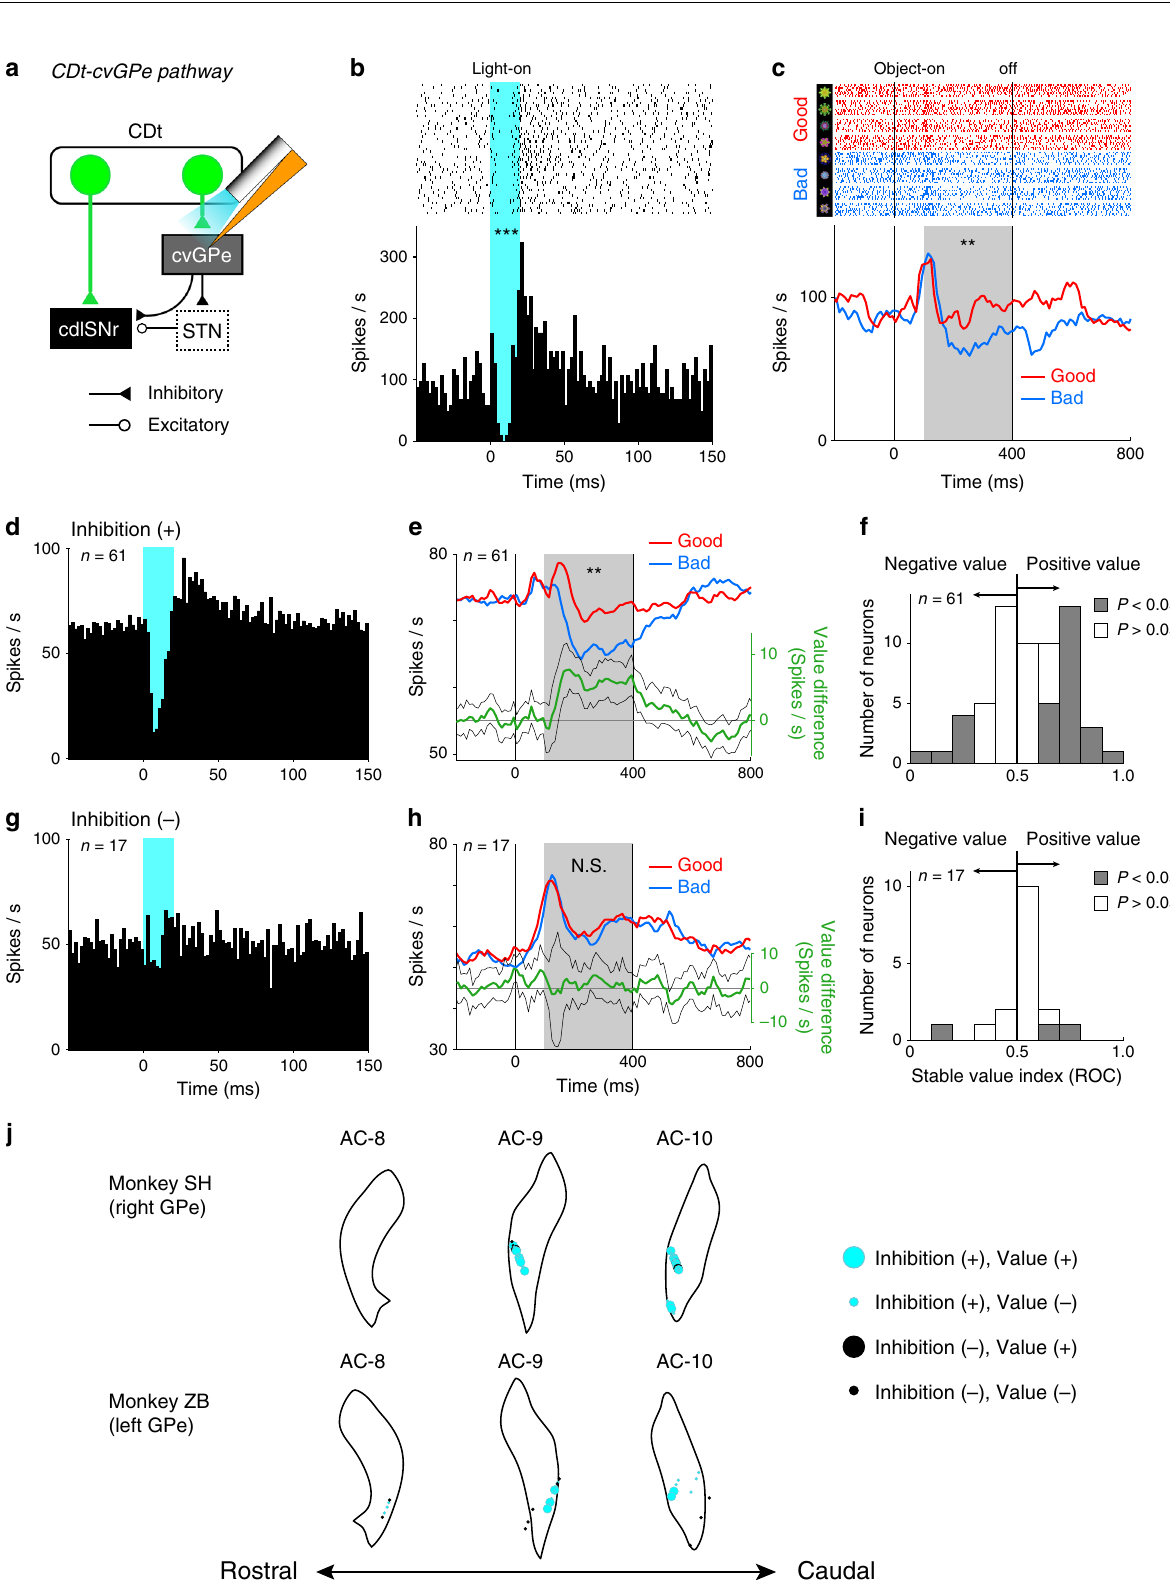
To investigate the effect of optical stimulation in cdlSNr on eye movements across all sessions, we plotted the cumulative difference in the number of contralateral saccades and ipsilateral saccades (Fig. 6d). The results indicate that the prevalence of contralateral saccades continued for ~200 ms both monkeys (Fig. 6d: monkey SH, Fig. 6e: monkey ZB), even though